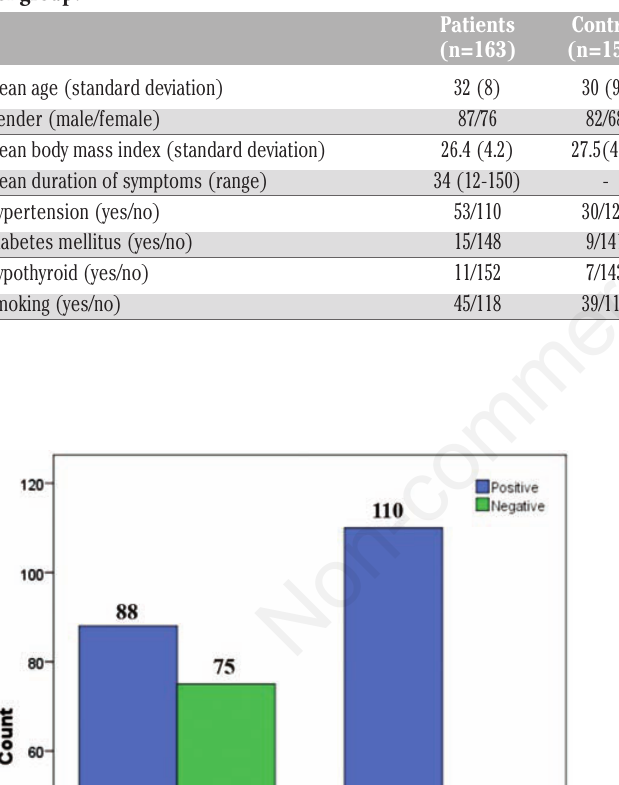
Table 1. Comparison between the baseline and clinical characteristics of patients and con- trol group.